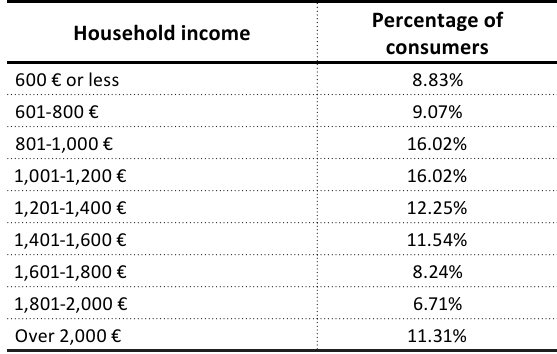
Table 1. Sample file structure based on